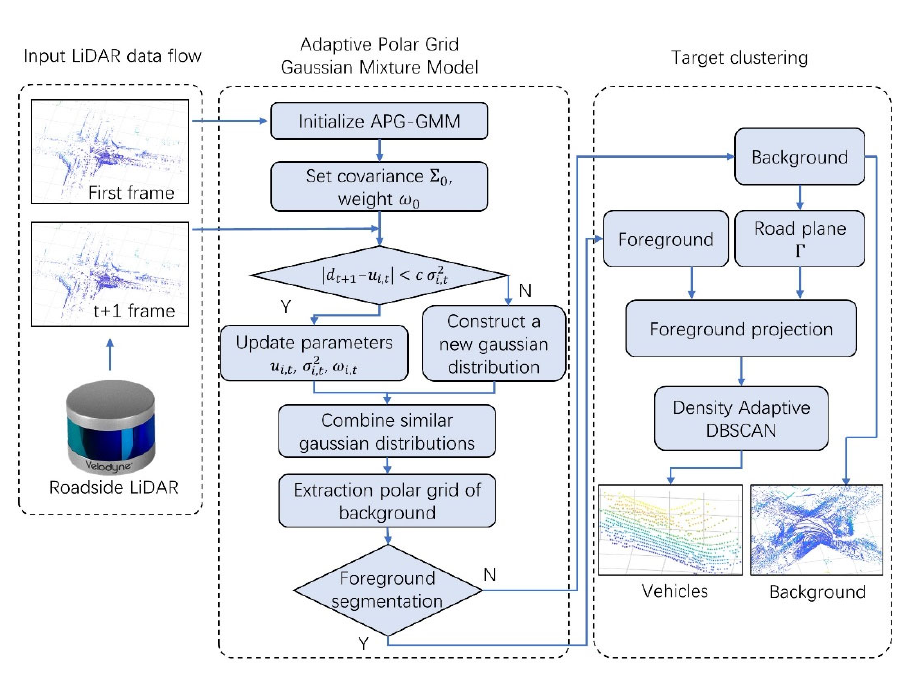
Figure 9. The flow diagram of the proposed